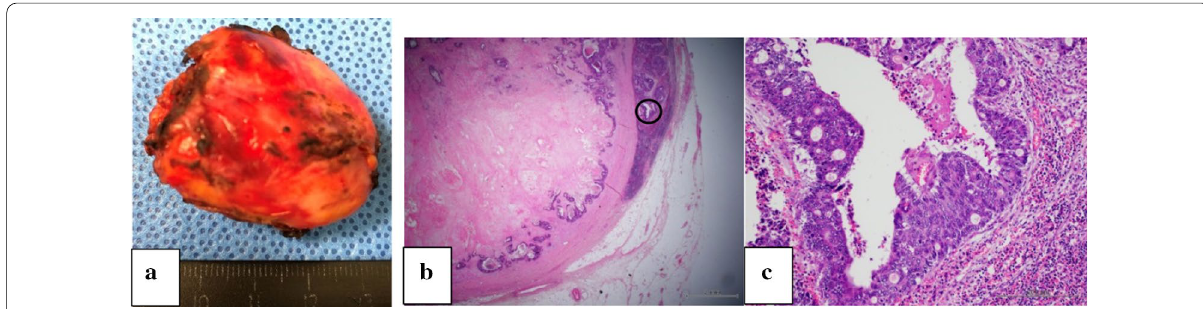
Fig. 9 a Resected specimen. b, c Histopathological analysis was consistent with a metastatic lymph node by colon cancer recurrence as moderately differentiated tubular adenocarcinoma. b H&E,